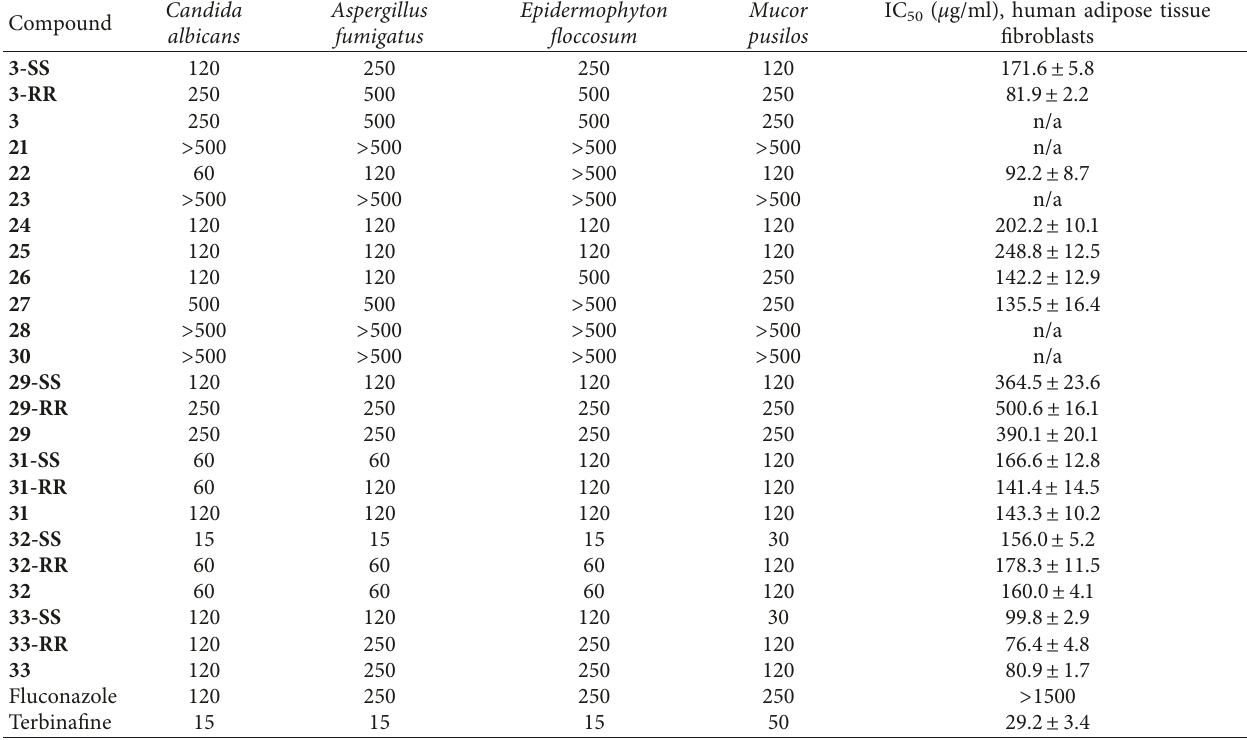
Table 2: Minimum inhibitory concentrations ( μ g/ml) of the synthesized compounds against the studied fungal strains.